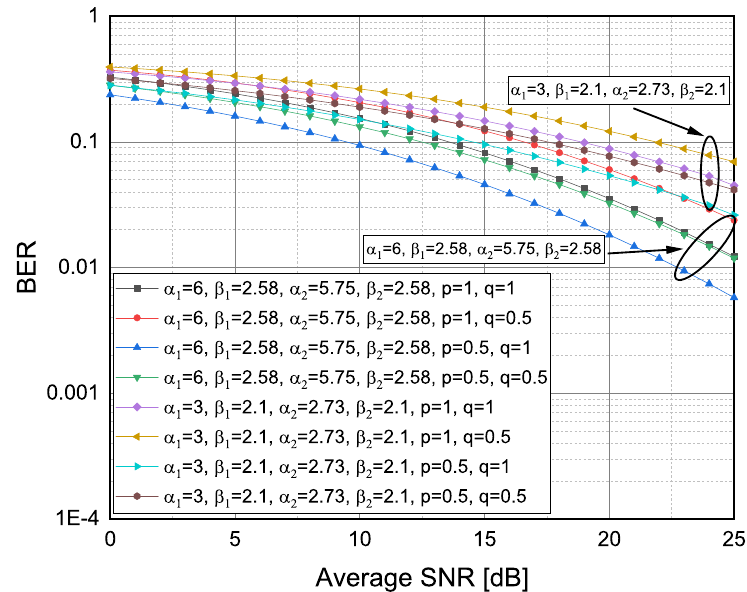
Figure 4. Average BER versus ¯ γ th observed for different TI fading severity conditions and different modulations technique.